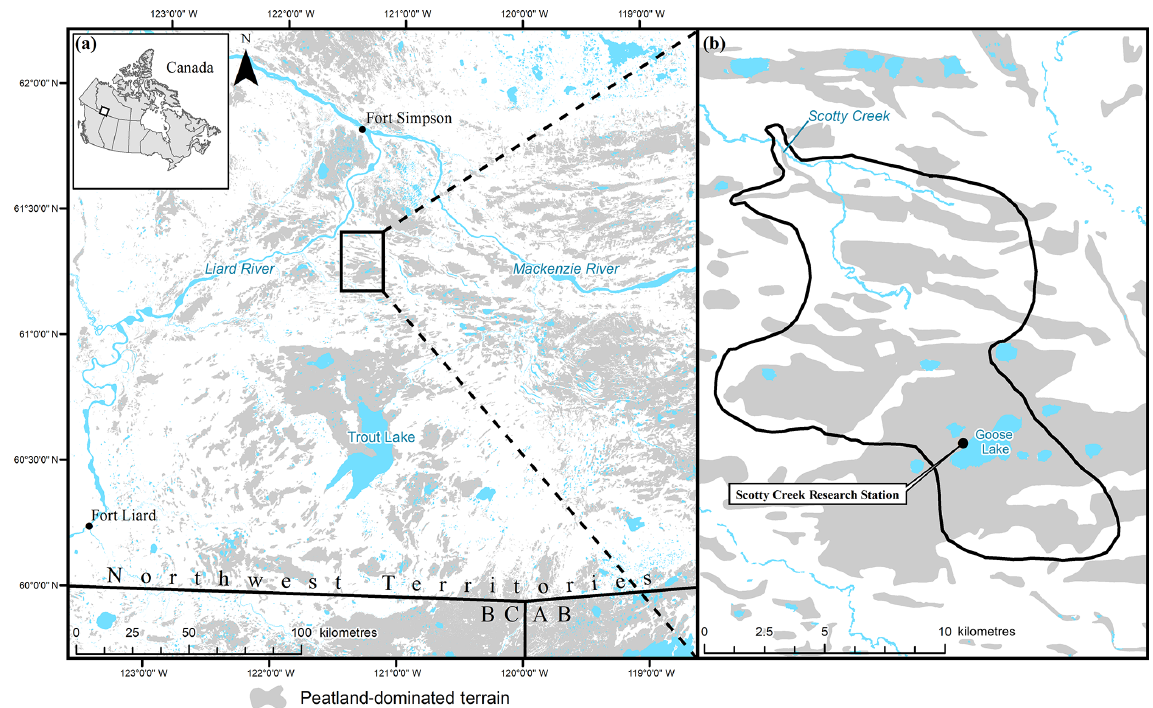
Figure 1. Distribution of wetland-dominated terrain containing discontinuous permafrost throughout the southern NWT (a) , including the Scotty Creek drainage basin (b)